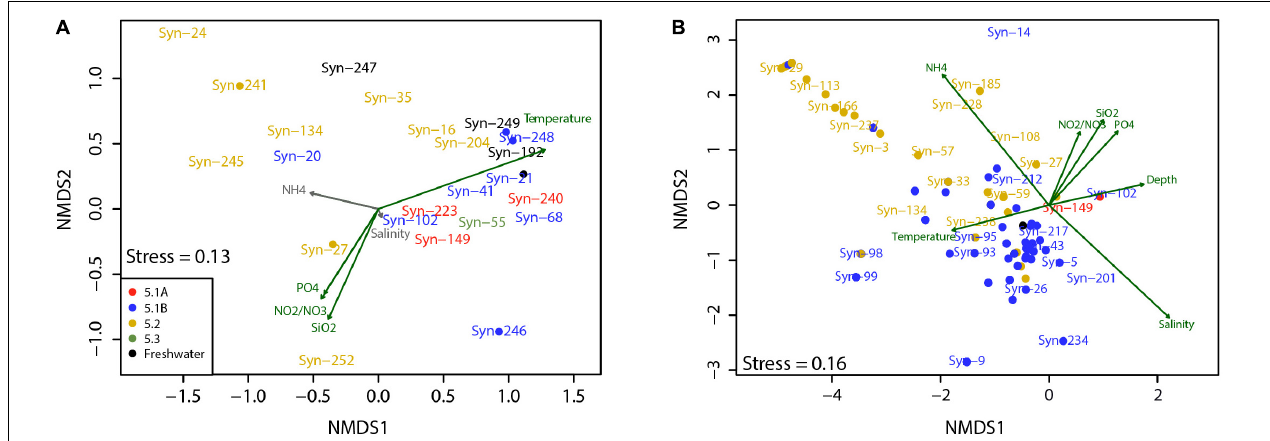
FIGURE 6 | Non-metric multidimensional scaling (NMDS) ordination of ASV relative abundance Bray–Curtis dissimilarities from (A) time series and (B) transects datasets. Points indicate overlapping ASVs in the ordination space. Environmental parameters with a significant correlation ( P < 0.05) to ordinations are shown in